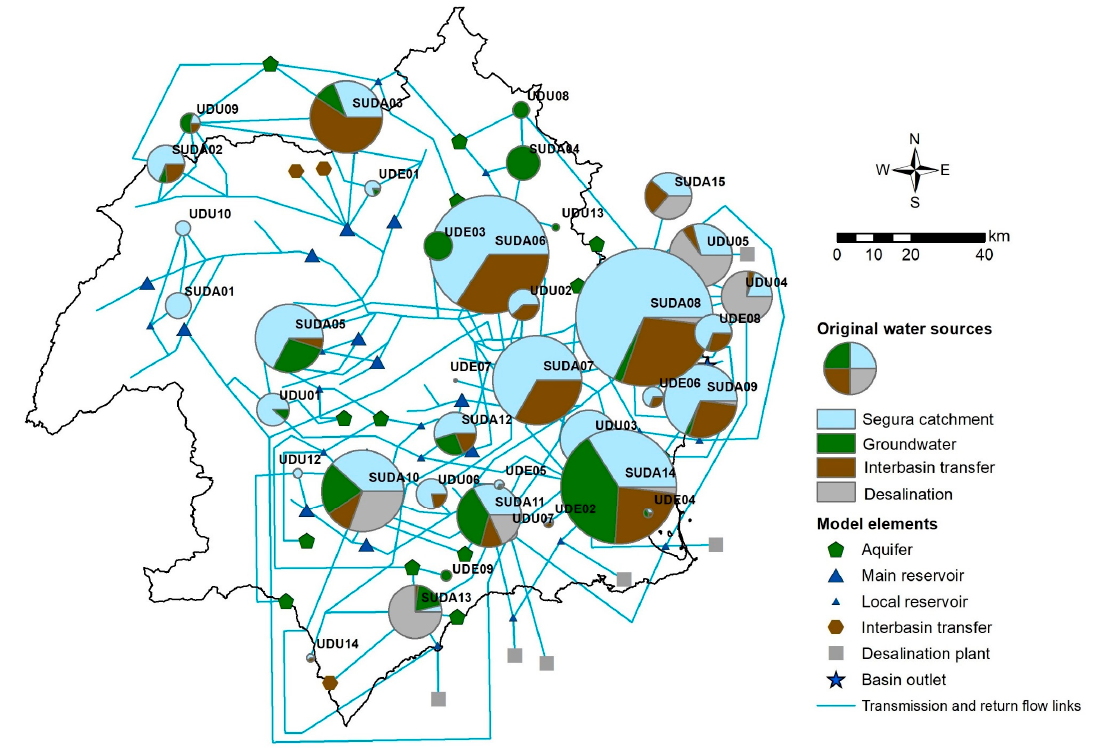
Figure 3. Original sources of water per demand site. Sizes of the pie charts are in proportion to total annual supply to each demand site. SUDA, UDU, and UDE refer to agricultural, urban, and environmental demand sites, respectively.